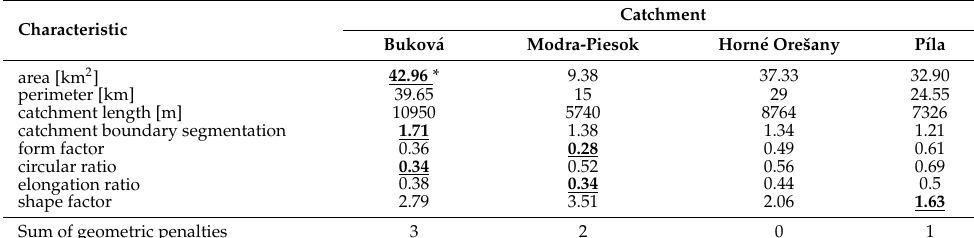
Table 2. The basic geometric properties of the